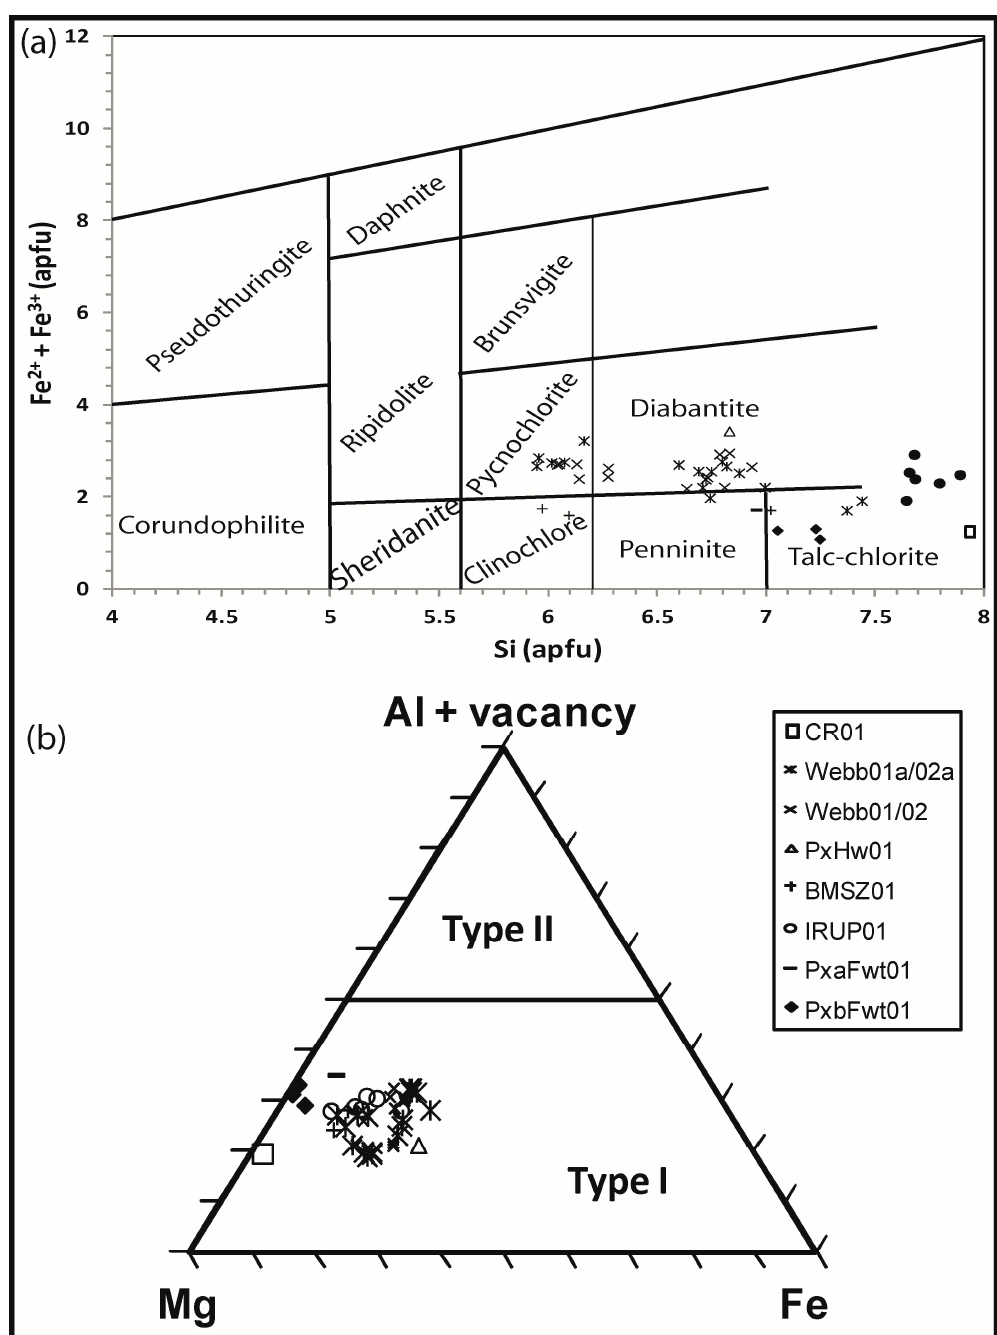
Figure 16. ( a ) Plot of chlorite analyses from the present study on a chlorite classification diagram of Hey (1954) [69]. Chlorite analyses from the MSZ plot in the pycnochlorite, clinochlore, diabantite, and talc-chlorite fields. ( b ) plot of chlorite analyses on at Al + vacancy, Fe and Mg ternary diagram (after Zane and Weiss, 1998 [88]) and all samples from the present study fall into Type I chlorites.